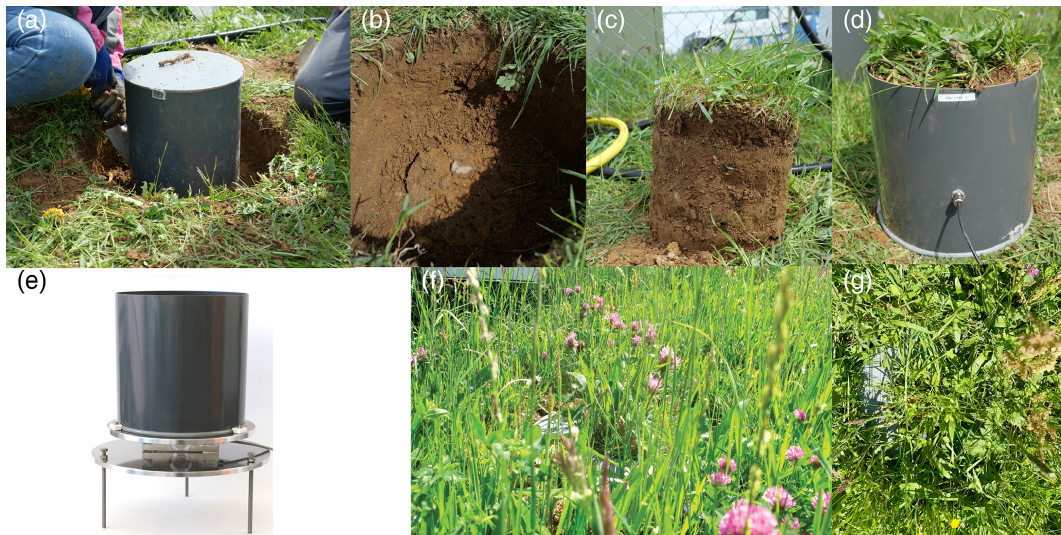
Figure B1. Photographs of single ML pots during (a–e) and after (f–g) installation at CH-FRU. (a) First step to retrieve an undisturbed soil monolith. An empty ML pot was placed upside down, and then the soil around the ML pot was removed with small shovels. Afterwards the ML pot was gently pressed into the soil. (b) The contact of the monolith with the soil was cut at the bottom with a spade. (c) The monolith was removed from the ML pot and carefully transferred to a second ML pot. (d) Monolith ready for installation at the weighing platform. (e) Empty ML pot on a weighing platform. The weighing platform is standing on the adjustable support feet. (f) Lateral view of an installed ML. (g) Top view of an installed